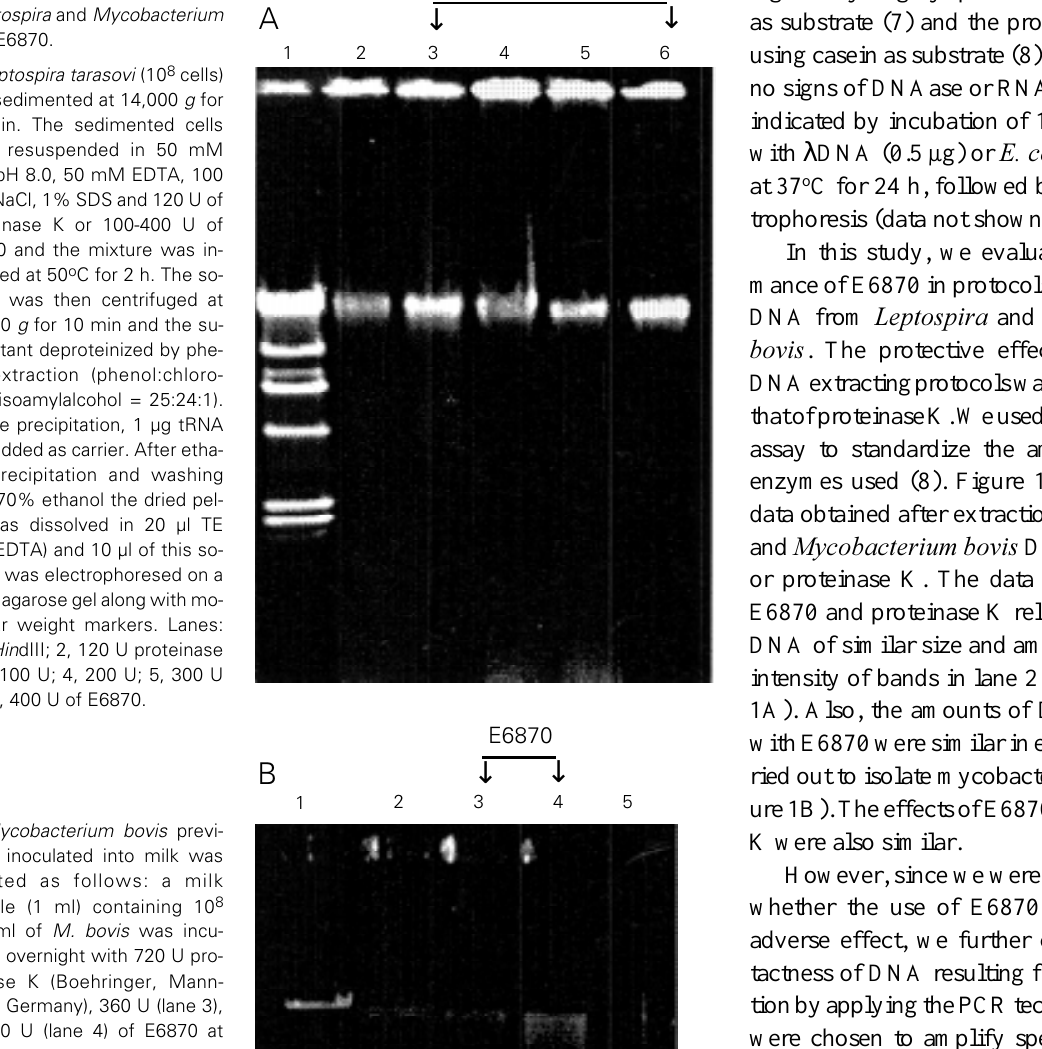
Figure 1 - Isolation of DNA from Lepstospira and Mycobacterium with